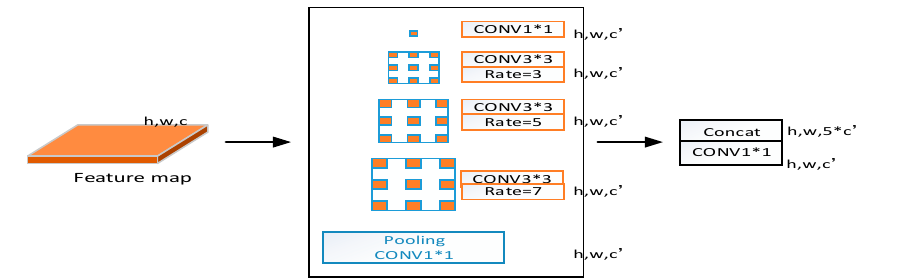
Figure 3. Atrous spatial pyramid pooling network (ASPPNet) structure.